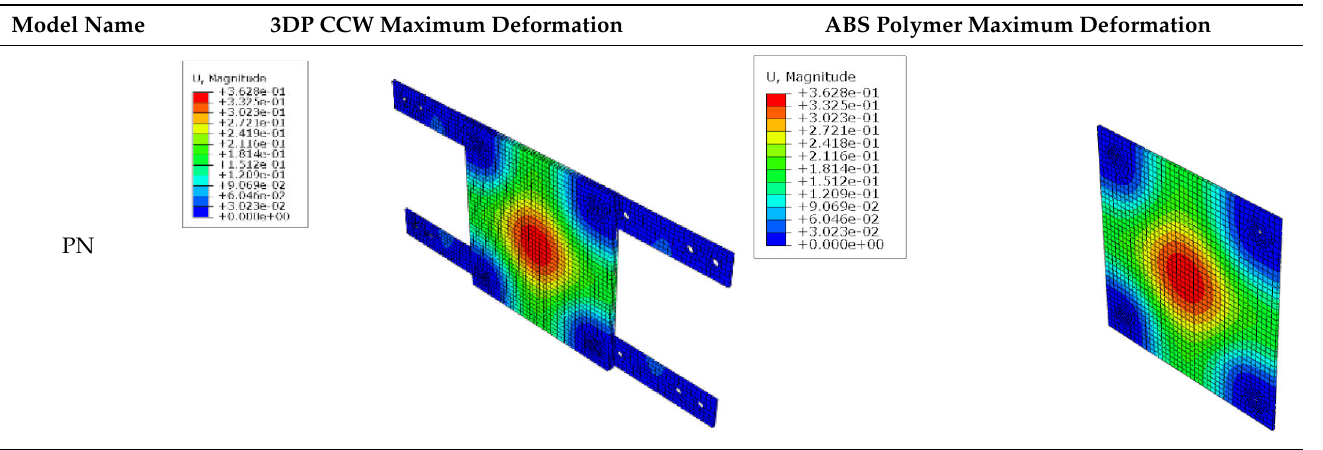
Table 8. FEM analysis